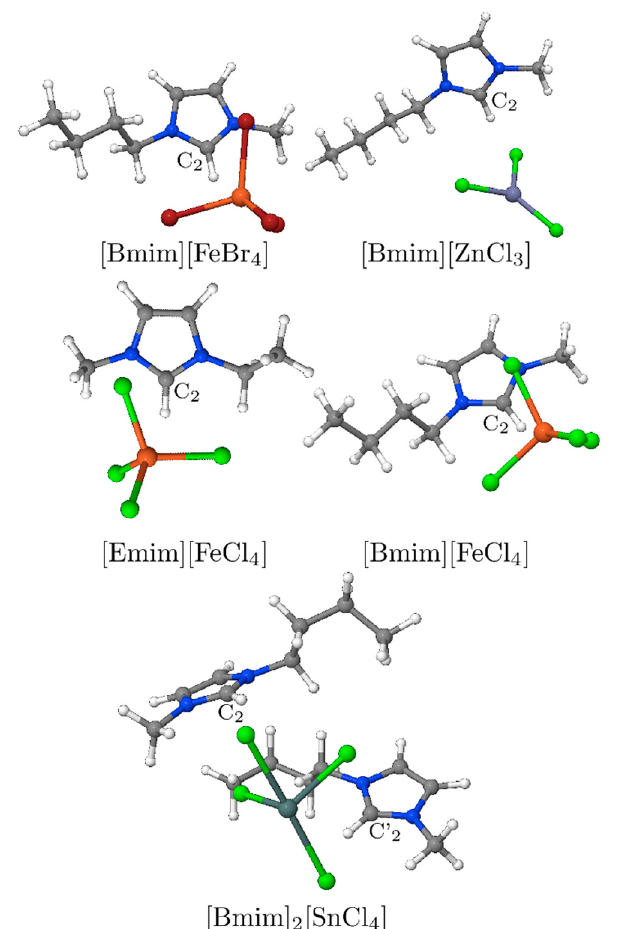
Figure 1. Structures of the different MILs investigated in this work.